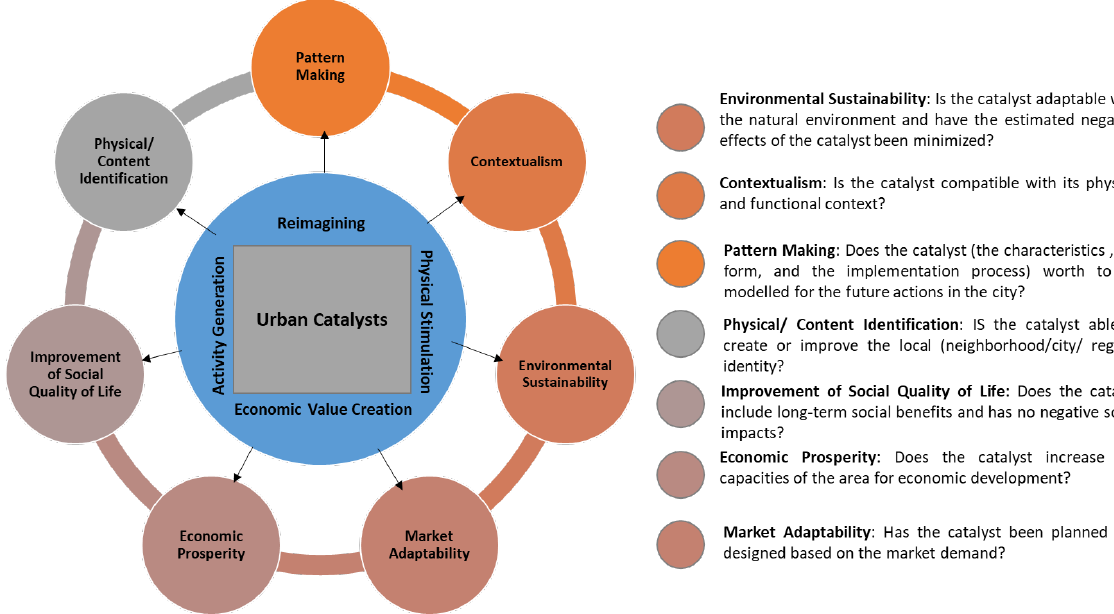
Figure 4. Questions for sustainability assessment of urban